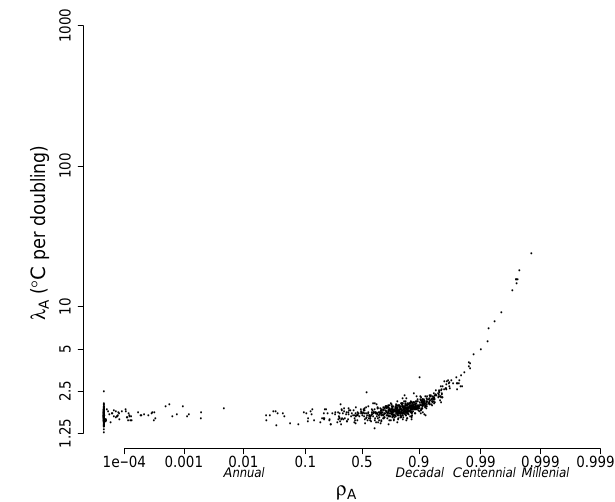
Figure 4. Distribution of the parametric bootstrap estimates of λ A and ρ A from model (4). It is difficult to distinguish between the rate of response and the sensitivity using only global mean temperatures from the recent